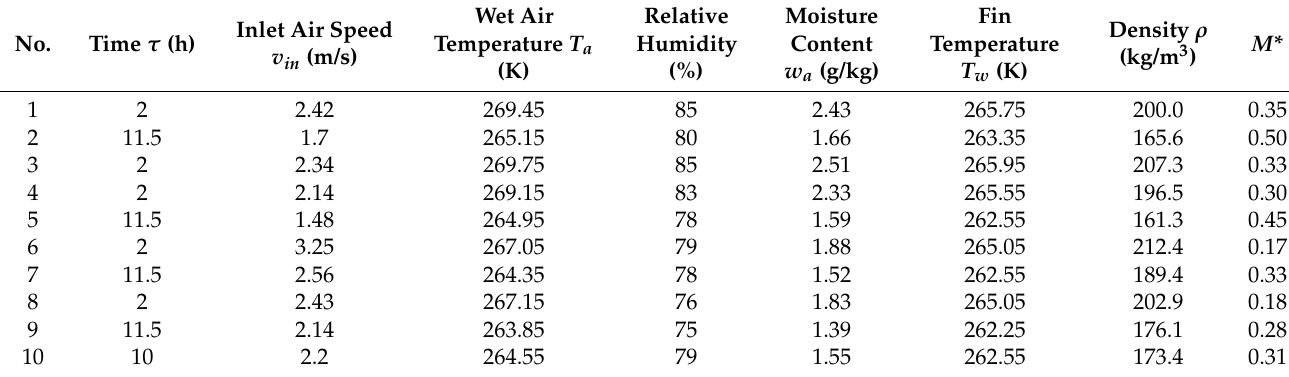
Table 6. Parameters of measured